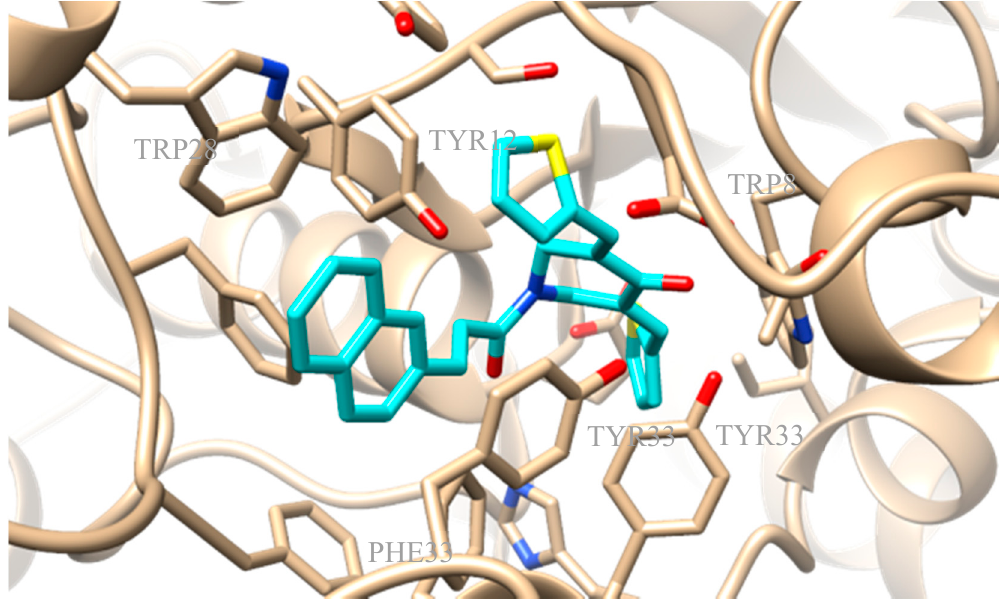
Figure 9. Preferred docking pose of 3e (depicted in cyan) bound to optimized complex 4EY7.